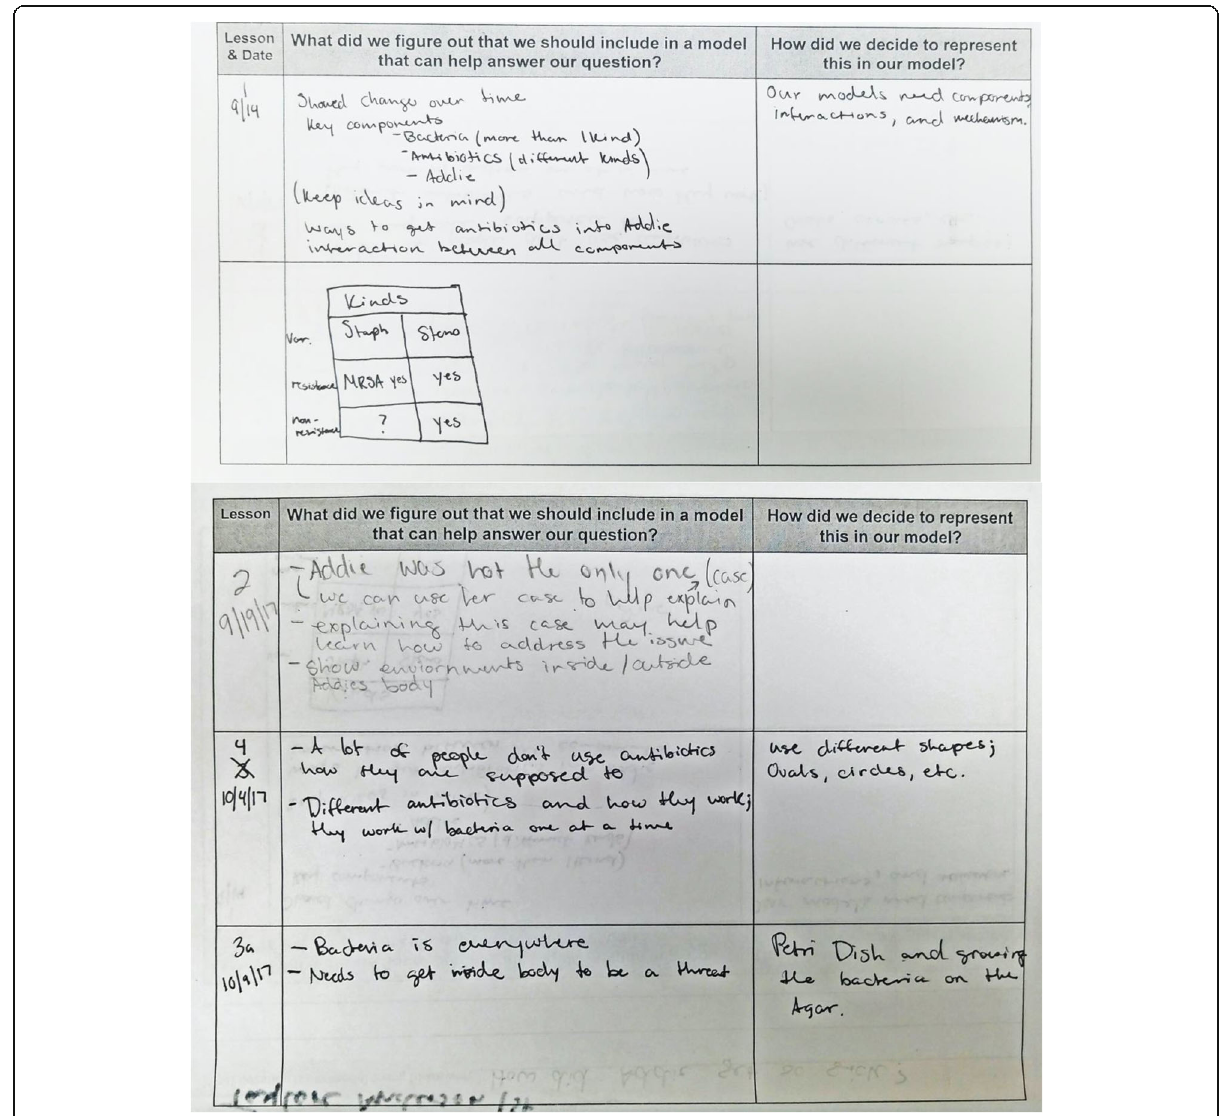
Fig. 5 Excerpt of a student ’ s progress tracker page. The left column includes important things that the student figured out in each lesson. In this classroom, the class used the right column to keep track of important